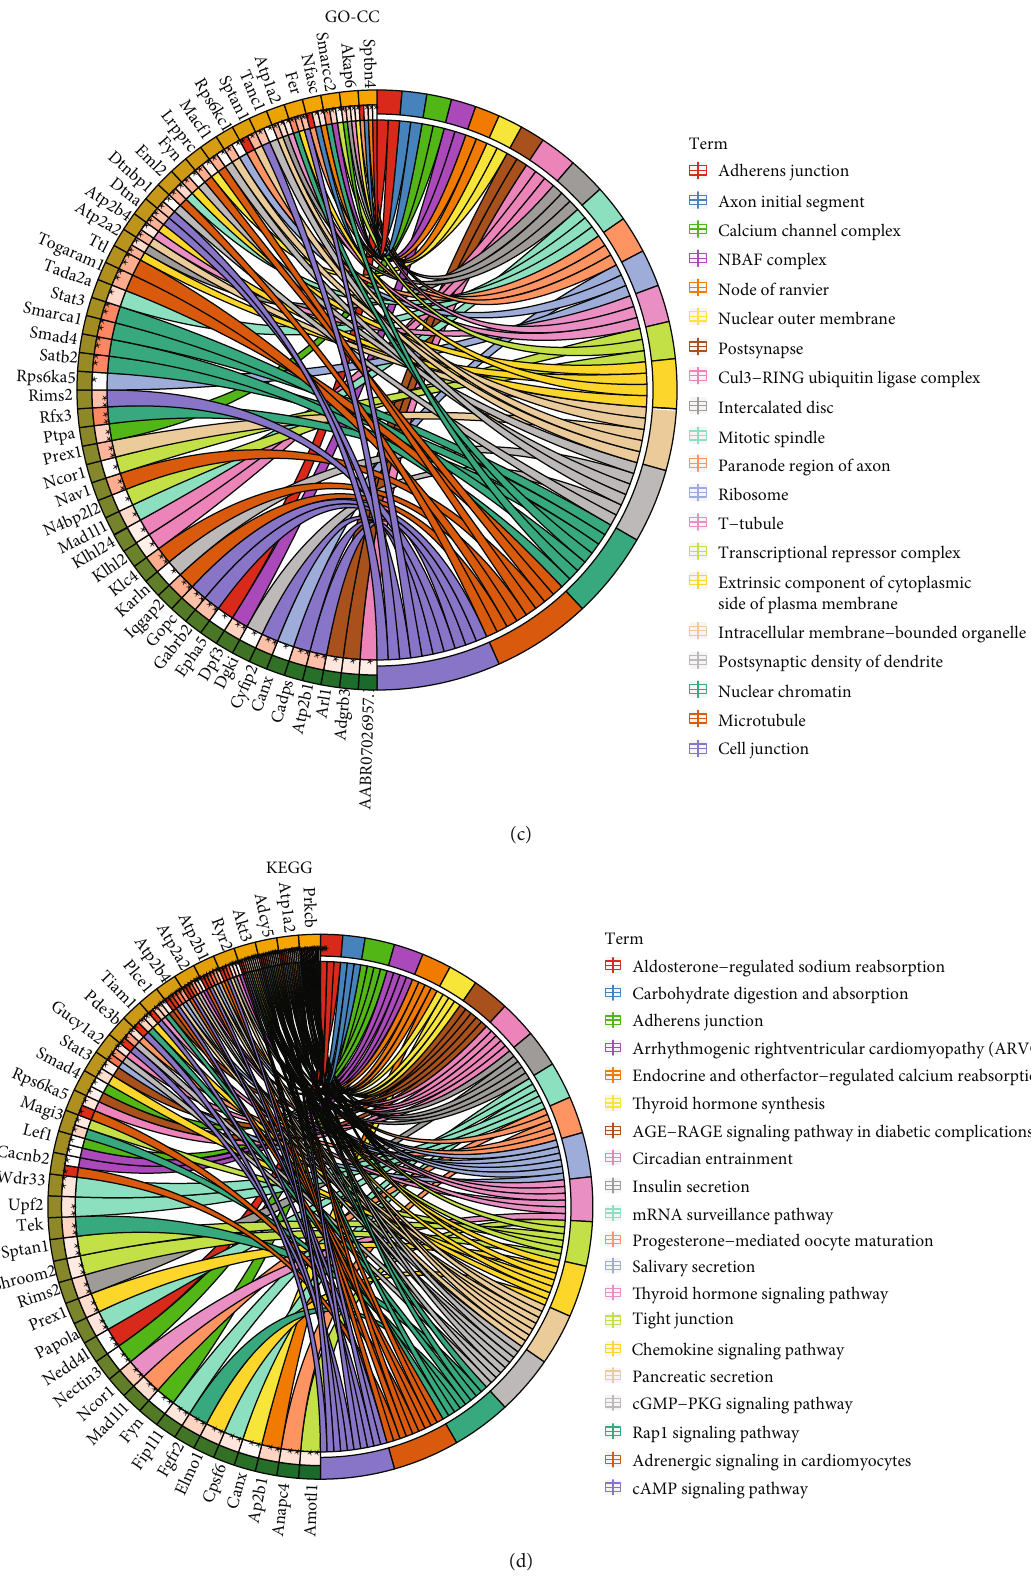
Figure 5: GO and KEGG analyses of host genes of DECs. (a – d) Circos plot diagrams showing the top 20 enriched (a) biological process GO terms, (b) molecular function GO terms, (c) cellular component GO terms, and (d) KEGG